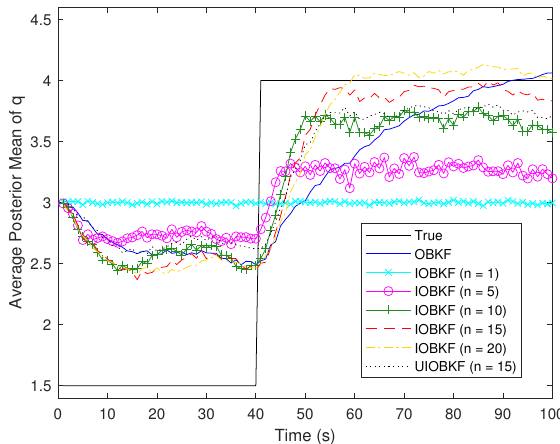
Figure 9. Estimation of noise parameter q .